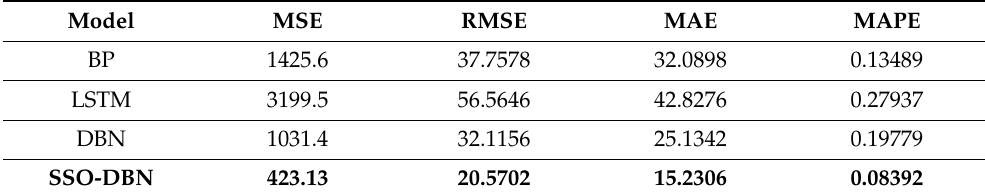
Table 3. Prediction results evaluation form (Wind